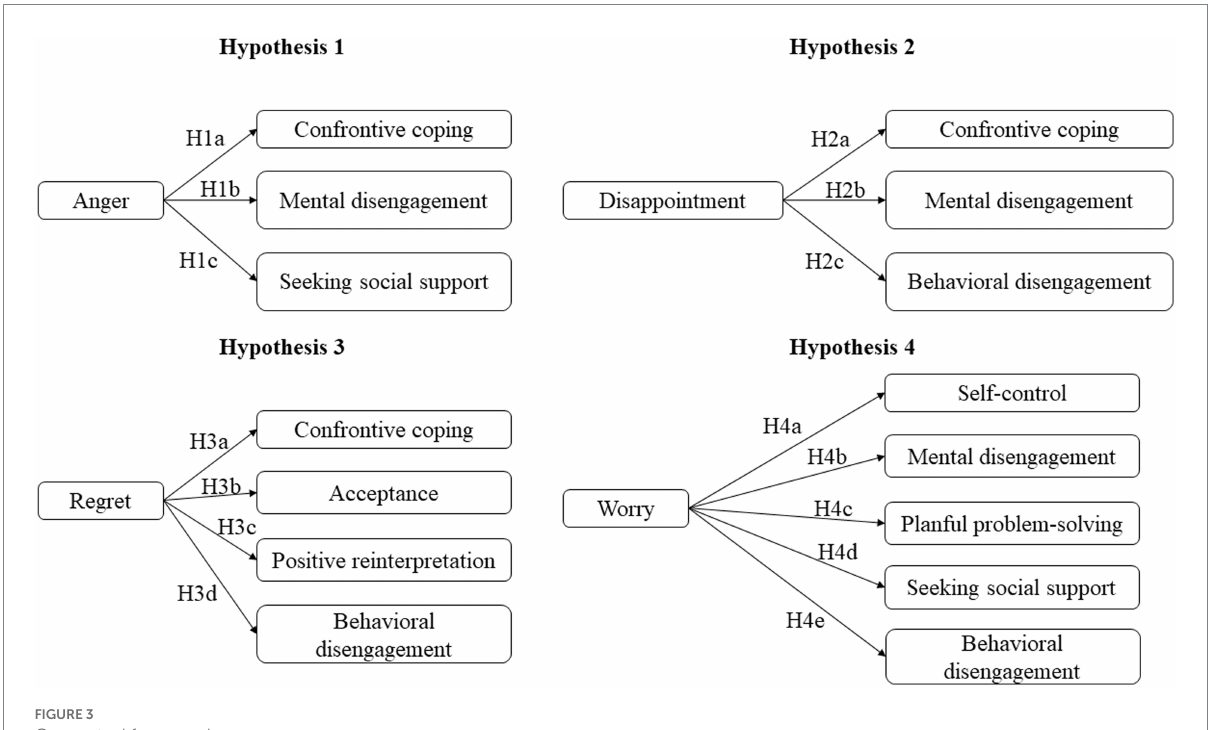
FIGURE 3 Conceptual